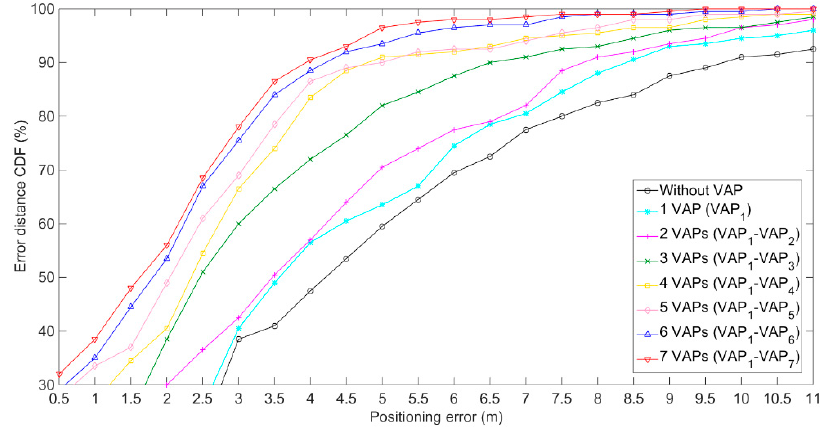
Figure 10. Positioning results of the VAP method for eight different numbers of VAPs.